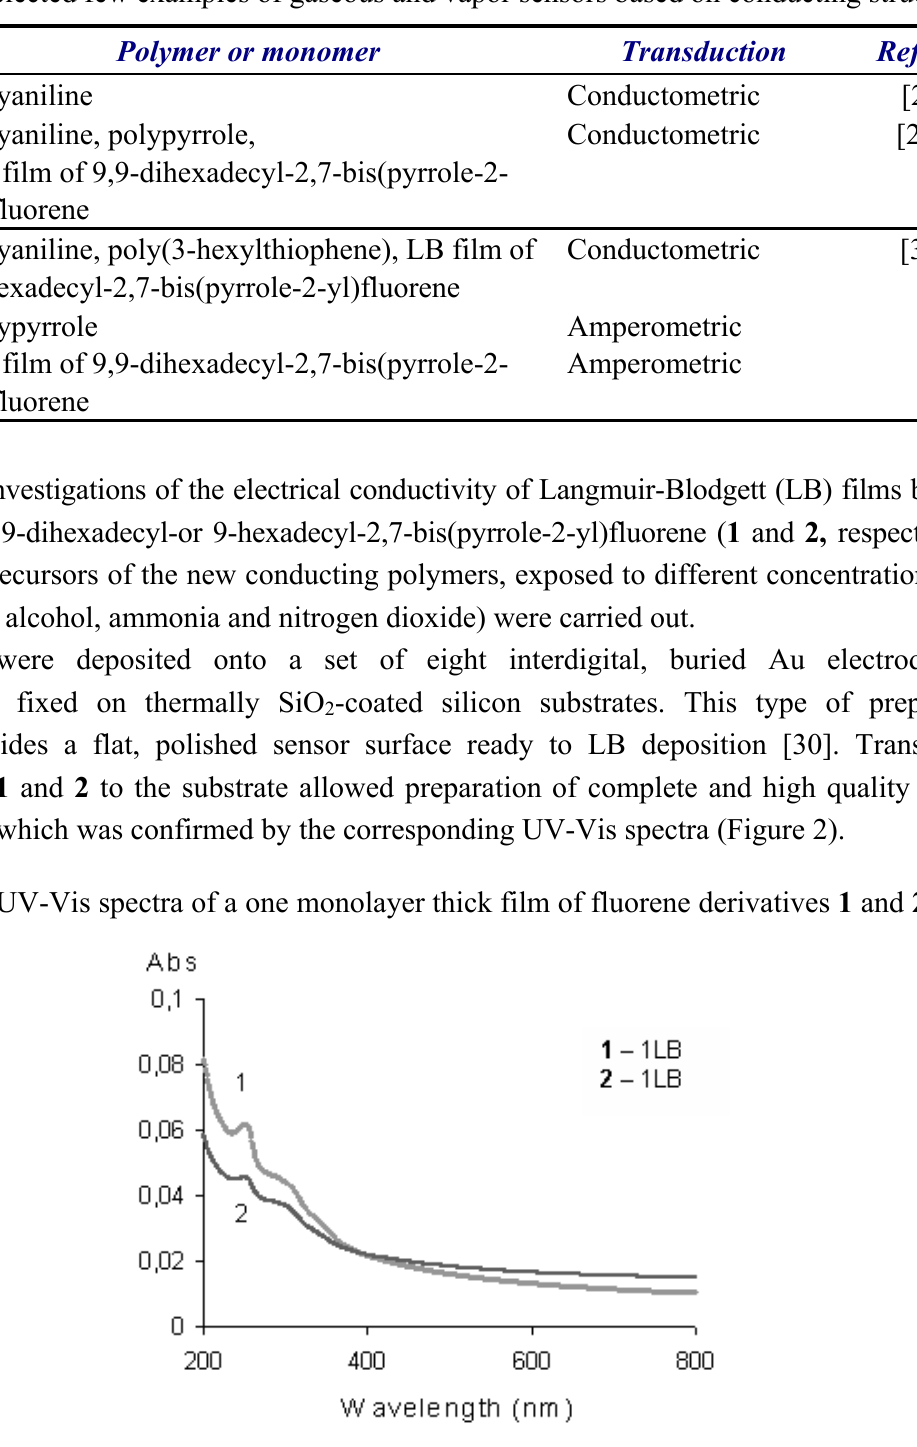
Table 2. Selected few examples of gaseous and vapor sensors based on conducting structures.